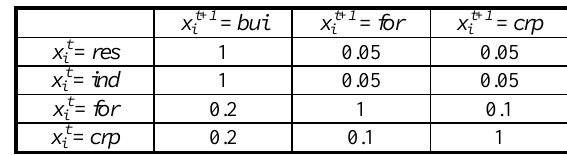
Table 1: Temporal transition matrix; t corresponds to the Ikonos image, t+1 corresponds to the Landsat image.